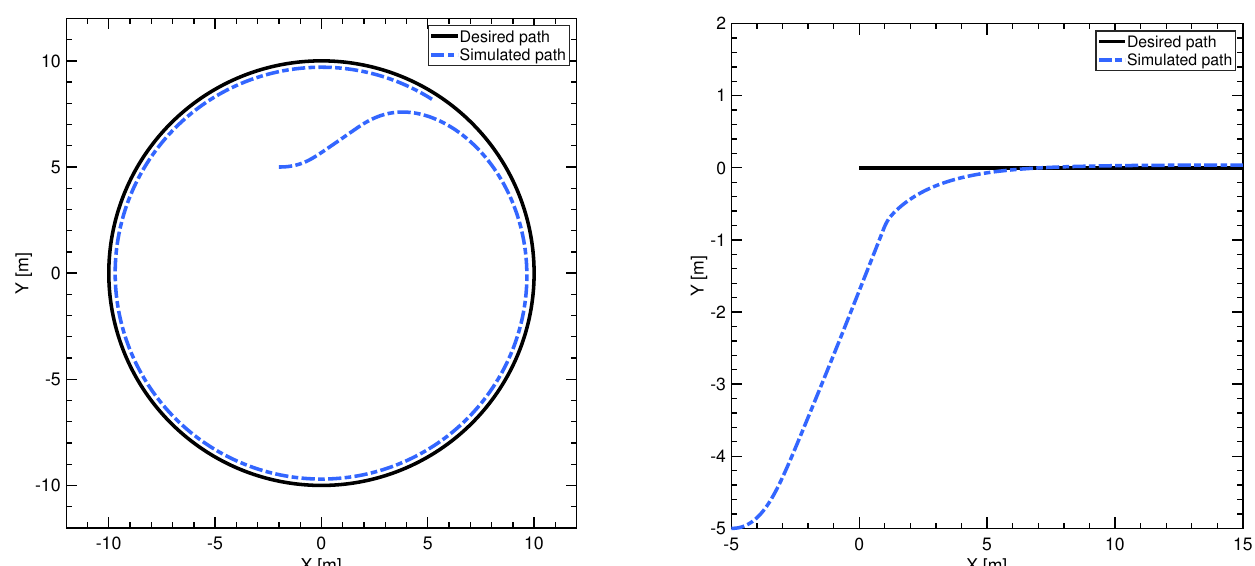
Figure 13. Trajectory following test in case of incorrect knowledge of incorrect mass and inertia: circular ( left ) and straight paths ( right ).